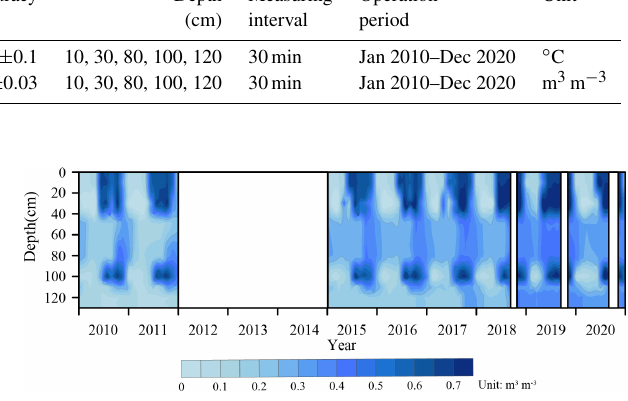
Figure 5. Evolution of soil volumetric water content profiles from 2010 to 2020 at the Mahan Mountain permafrost site. The blank gap stands for the missing